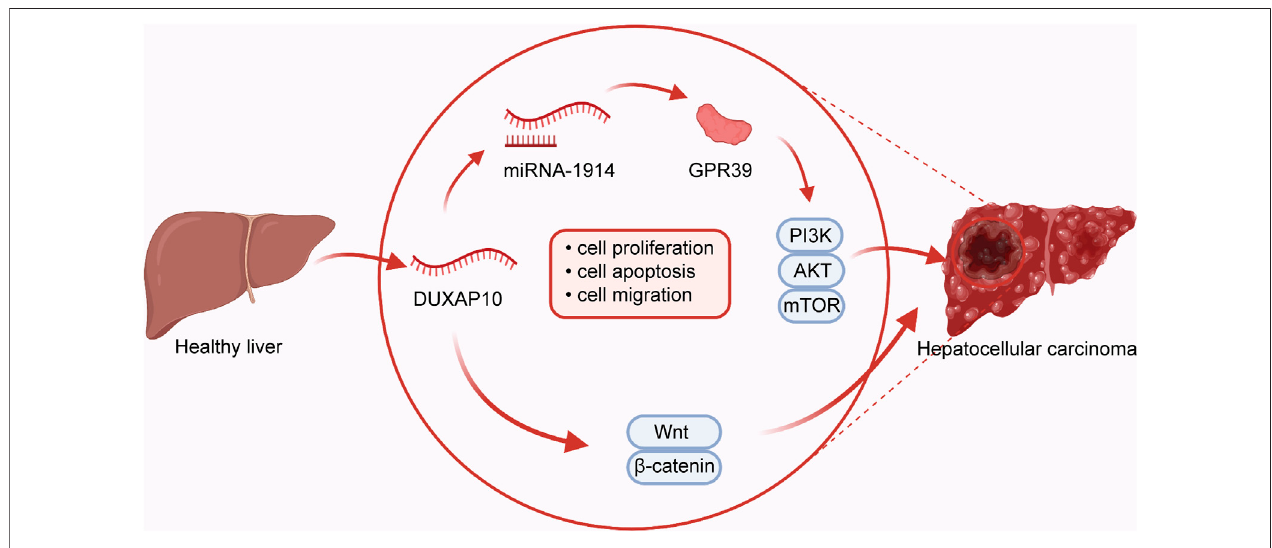
FIGURE2| Inhepatocellular carcinoma, DUXAP10 plays anoncogenicrole inregulatingthe processesofcellproliferation, apoptosis, and migration bycombining with microRNA-1914 and further activating the GPR39-dependent PI3K/AKT/mTOR pathway or Wnt/ β -catenin pathway.